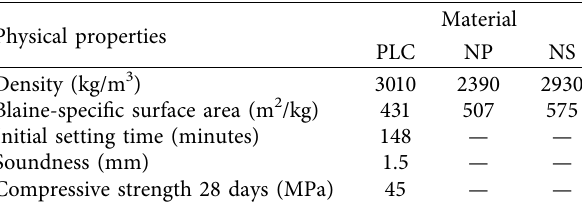
Table 4: Physical properties of PLC, NP, and NS.